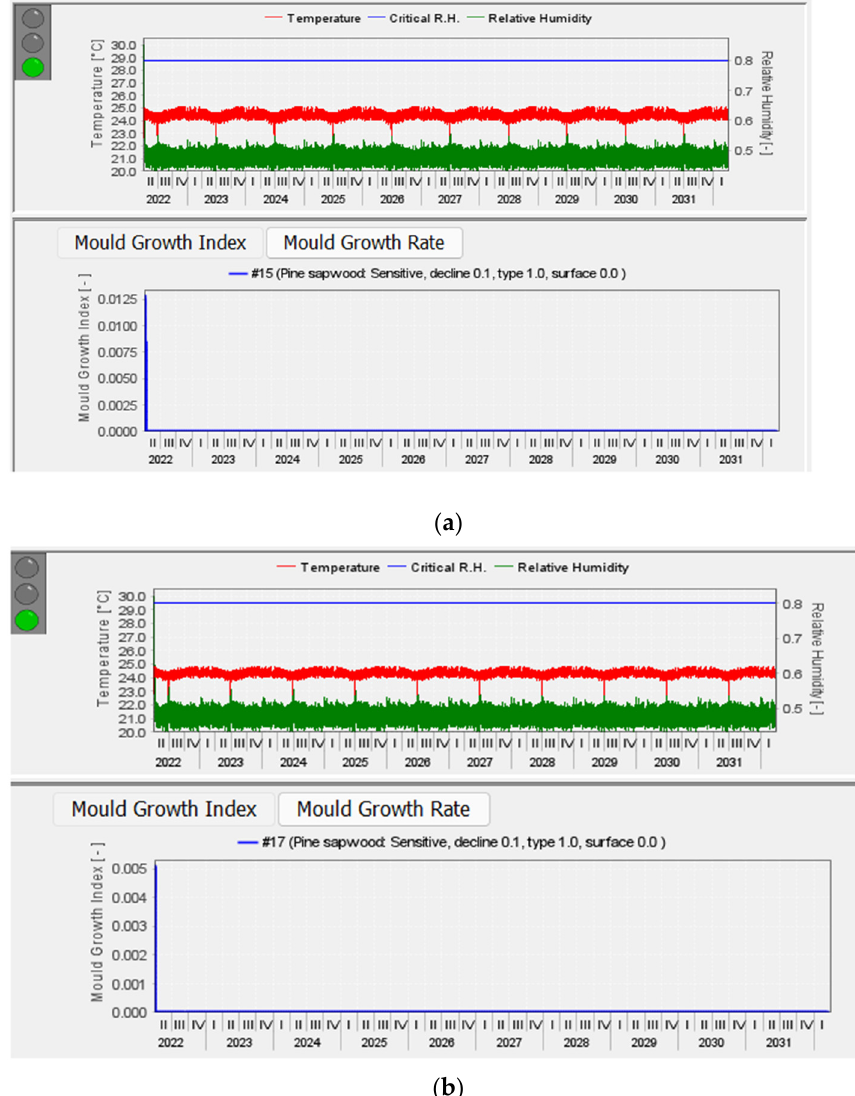
Figure 20. ( a ): Typical Mould Growth Index graph for the wall assembly with single point resistivity value of membrane B, C, D, and E in both north and west orientation of Australian hot and humid climate; ( b ): typical Mould Growth Index graph for the wall assembly with multipoint resistivity value of membrane B, C, D, and E in both north and west orientation of Australian hot and humid climate.